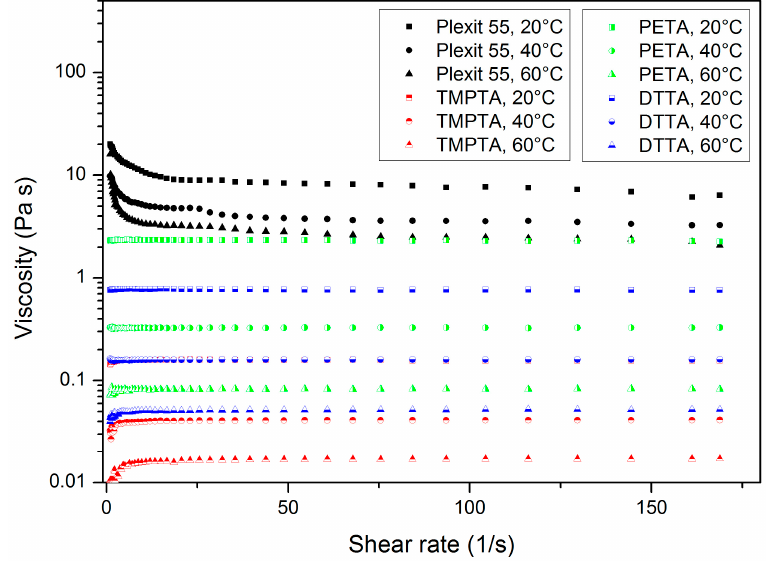
Figure 2. Shear rate and temperature-dependent viscosity of all investigated pure components.